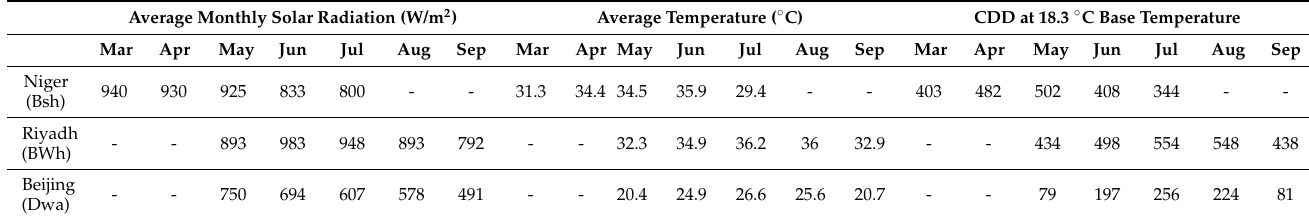
Table 4. Average solar ambient temperature and monthly cooling load.